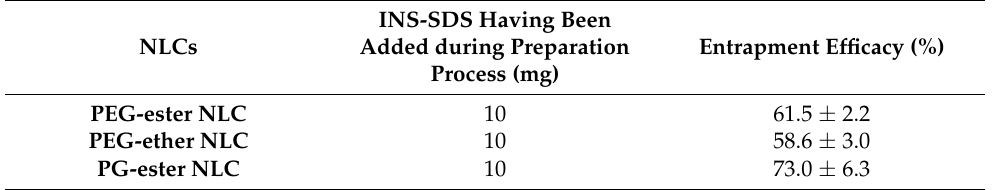
Table 2. Amount of INS-SDS complex having been added during the NLCs preparation process and